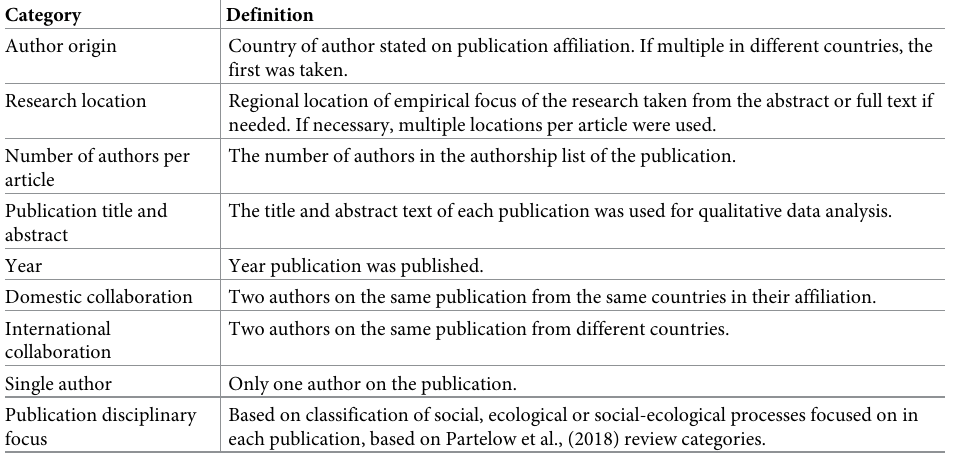
Table 2. Review categories and definitions used in this